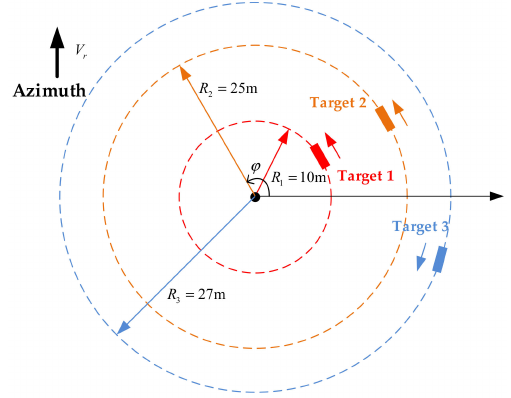
Figure 14. Moving target experiment. Table 1. Simulation